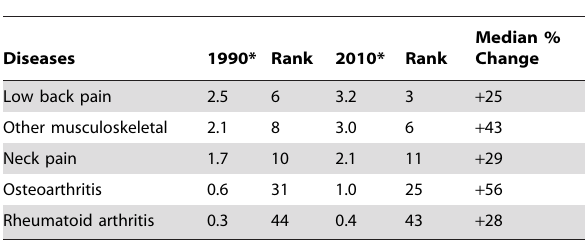
Table 3. Summary of trends in GBD DALYs in the United States for the Musculoskeletal Disease Subcategory with corresponding rank amongst all other diseases for 1990 and